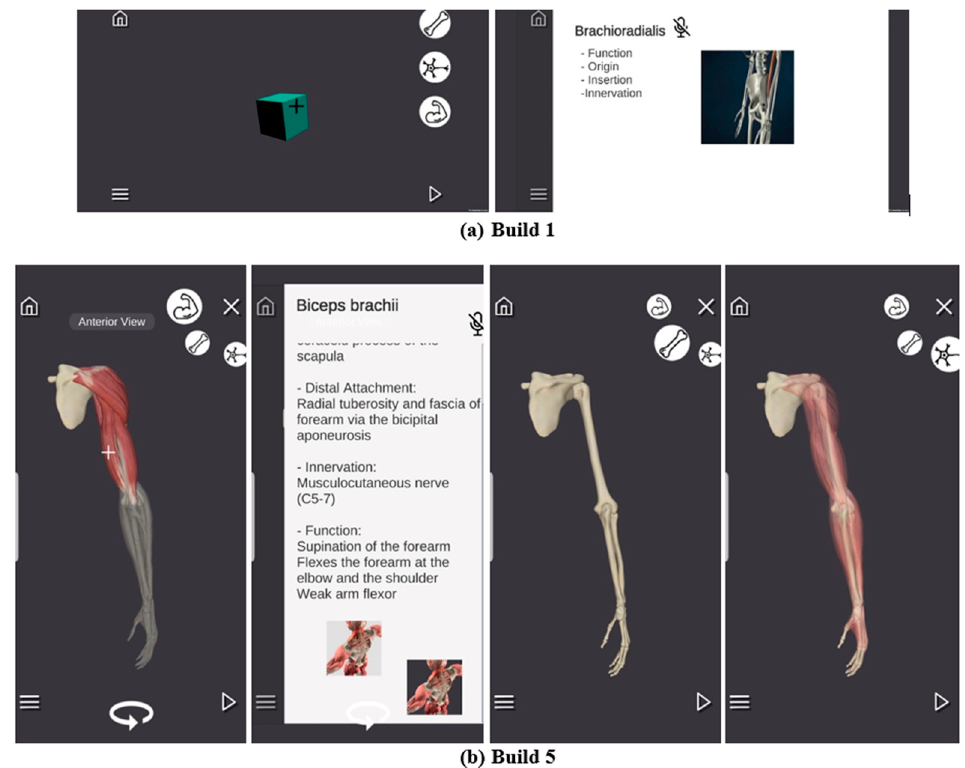
Figure 4. The changes made to the 3D mode, including final UI design and placement, during application development.